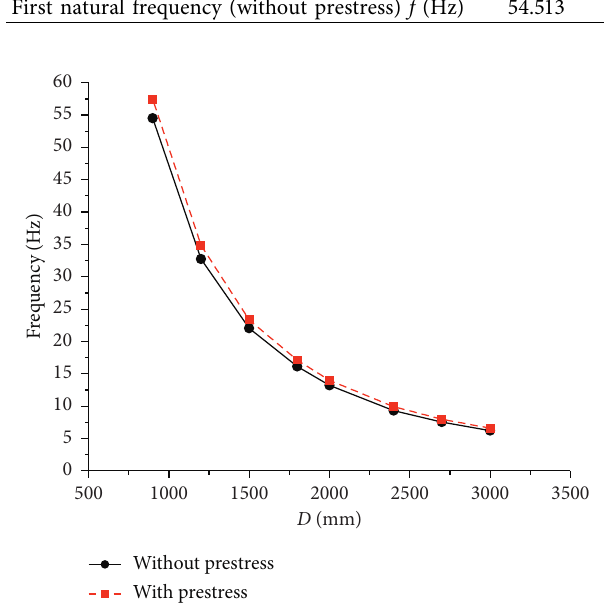
Figure 8: Influence of the prestresses on the first natural